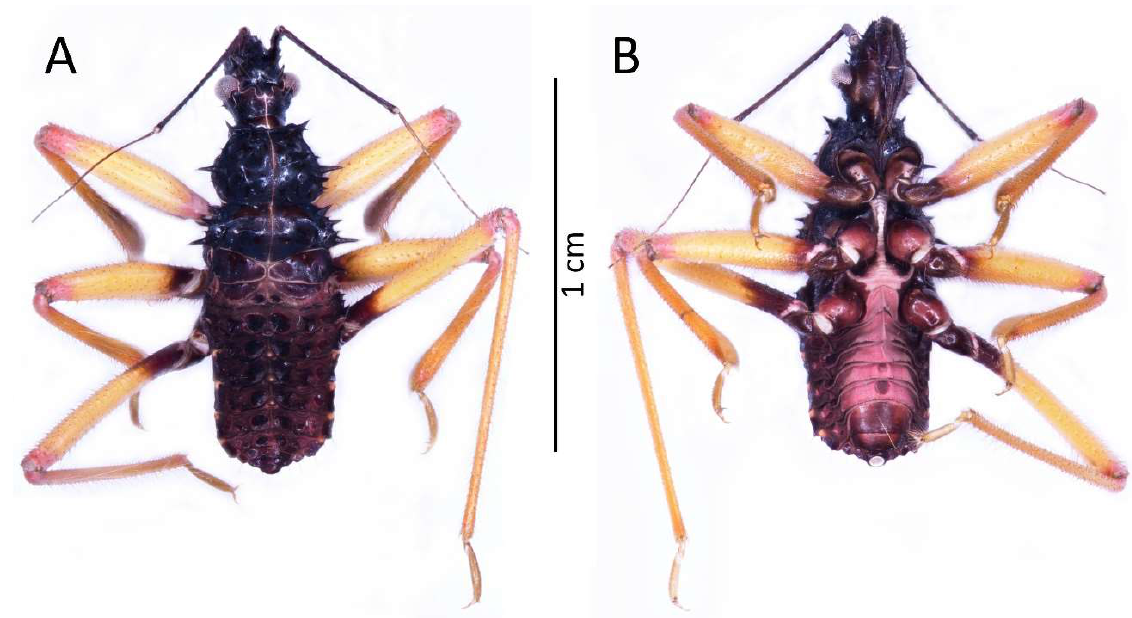
Figure 9. ( A ) Dorsal and ( B ) ventral habitus of the third instar of Psyttala horrida (Stål, 1865). Structure: Whole head more sclerotised, ecdysial lines thinner. Ante- and postocular part of the head with same number and placement of spine-like processes, larger than in second instar. Thorax dorsally covered by small granulations on most of its surface. Compared to the previous stage, the pronotum with visibly elongated large and robust processes, with a delicately elongated apical part. Spine-like processes visible on the pronotum with the same number and placement as in second instar but visibly larger. Spine-like processes mesonotum: I transversal row: two lateral, medium-sized processes; II transversal row: four processes—two long, lateral, placed on the edge or lobe, and two very small, visible in the middle; III transversal row: four large processes (inner ones larger) with additionally two small lateral processes visible on the edge of the lobe. Lateral plates of mesonotum with two large lateral processes and two medial, distinctly visible granules. Pad of barbed setae covering 1/3 of the apical part of foretibia and 1/4 of midtibia. Legs covered by relatively long and dense setae, distinctly denser on the ventral part of fore- and midfemur and tibia. The number and the placement of spine-like processes on the abdomen are the same as in second instar, except they are visibly longer. Three evaporatory areas of dorsal abdominal glands placed on globular enlargements, distinctly visible but not so sclerotised as other elements of tergites. Ventral surface of abdomen with visible, sclerotised muscle attachments. Middle part of IV–V abdominal segments with small sclerotisations. Abdominal segments VI–VII with large sclerotised areas ventrally (Figures 9 and